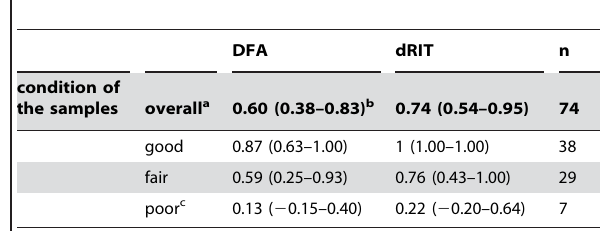
Table 5. Retesting of dRIT and DFA at CDC: Simple Cohen’s kappa coefficients calculated by comparing the